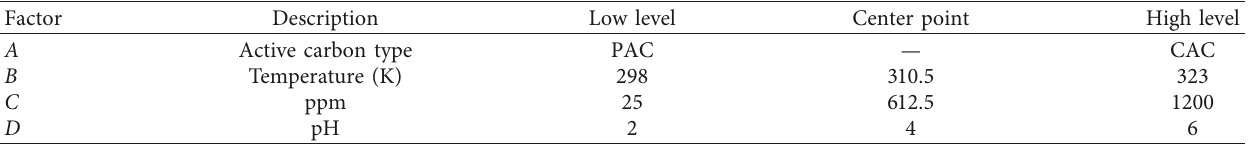
Table 2: Controllable factors and their levels.